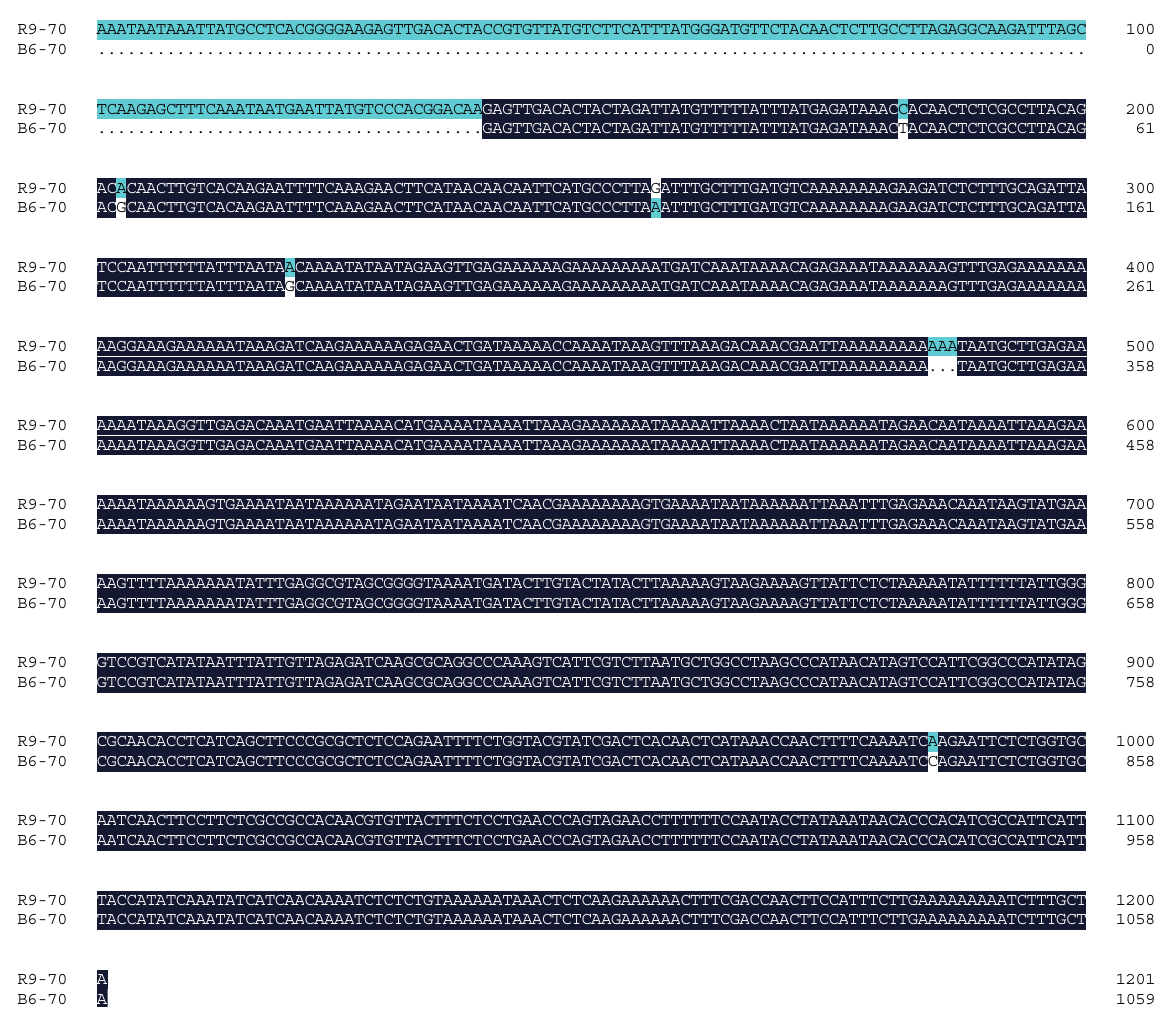
Figure 7. Alignment of promoter sequences of CaHsp70-1 from B6 and R9. Dark color indicates the consensus sequences, and light color indicates the different